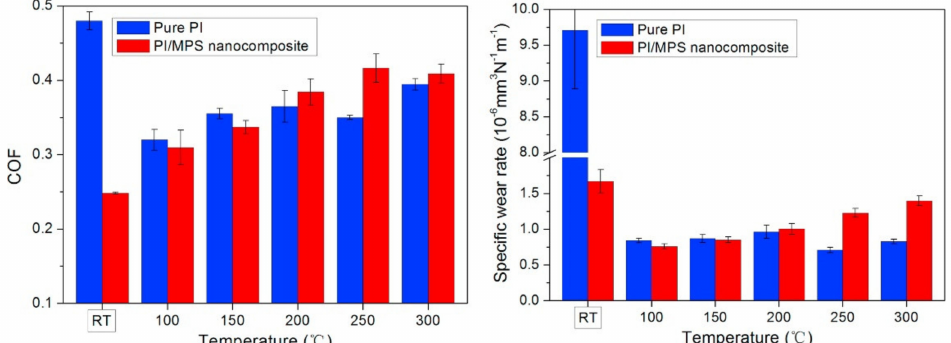
Figure 10. Friction coefficient and wear rate of PI and MPS/PI nanocomposites as a function of sliding temperature (Reproduced with permission from J. Ma, X. Qi, Y. Zhao, Q. Zhang, Y. Yang, Wear; published by Elsevier, 2017)